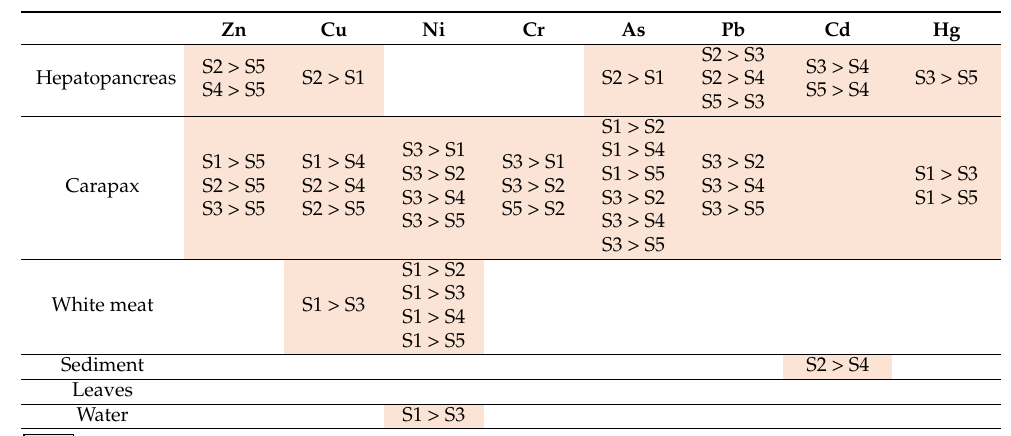
compartments at the five stations.